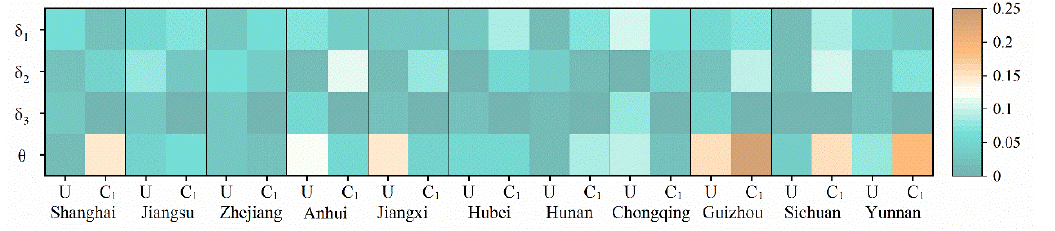
Figure 5. Sensitivity analysis results.